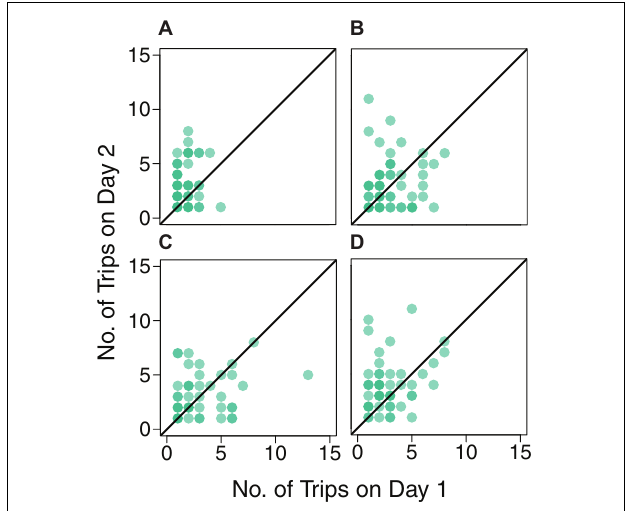
FIGURE 5 | Number of foraging trips on Day 1 by number of trips on Day 2 for colonies (A) 859, (B) 1107, (C) 1242, and (D) 1368 (correlation coefficients 0.13, 0.16, 0.28, and 0.26, respectively). Each dot represents a forager. The black line is the y = x line representing a model yielding a correlation coefficient of